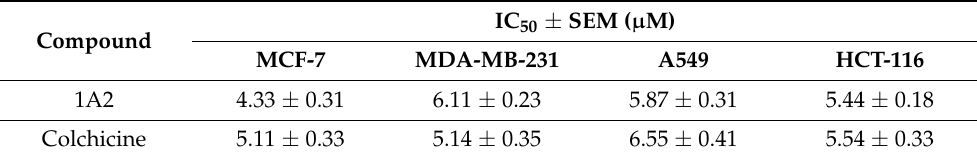
Table 2. In vitro antiproliferative activity (IC 50 in µ M) of compound 1A2 against MCF-7, MD-MB-231, HCT-116, and A549 cancer cell lines.